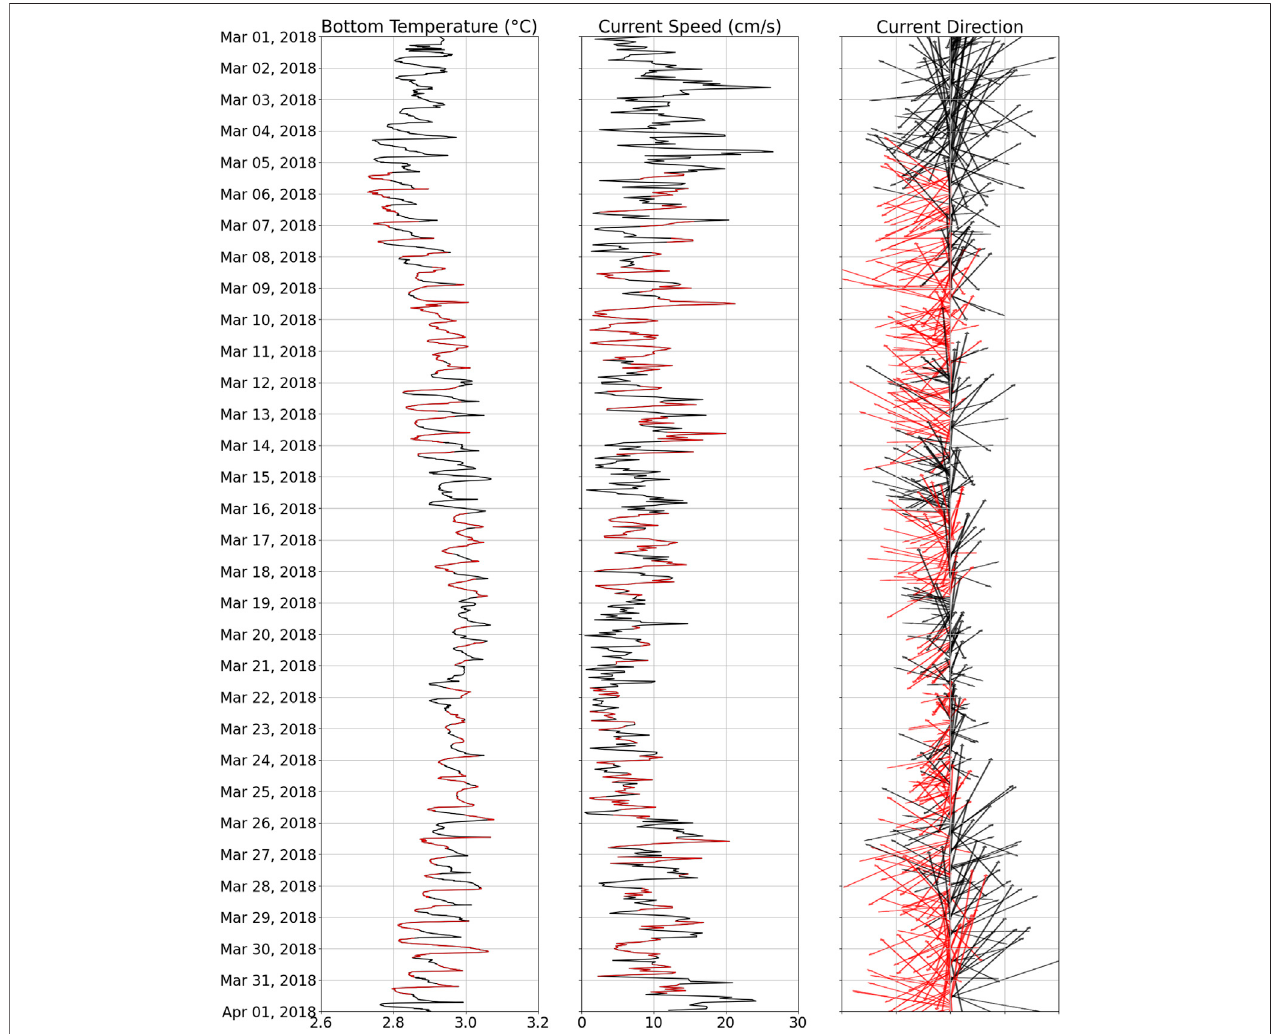
FIGURE 8 | Temperature, current velocities and current directions of bottom waters in March 2018. On the current direction plot, the North is up and the length of the arrows re fl ects the current velocity. The red colors indicate times with no gas emissions. Periods of inactivity are more frequent when the bottom currents have a westward trend. The plots for the entire ADCP monitoring period are provided in the Supplementary Figure S2